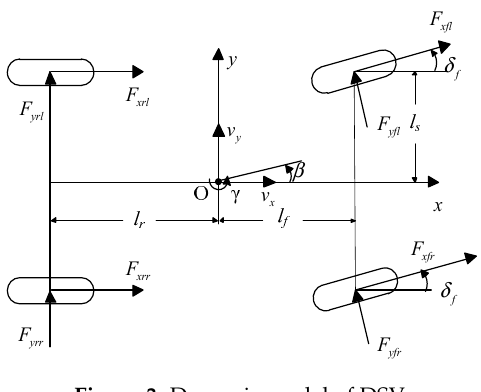
Figure 3. Dynamic model of DSV.